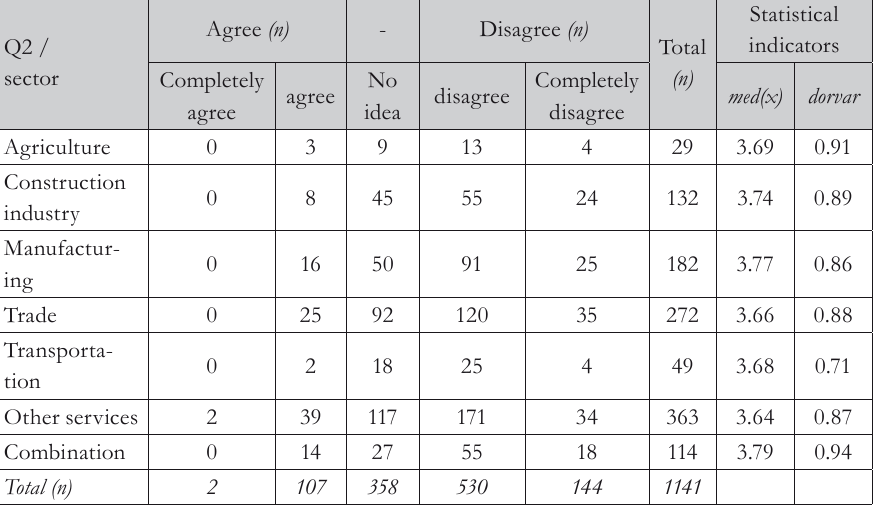
Tab. 5 – Pivot table for Q2a absolute frequency and Statistical characteristics. Source: authors Agree Q2 / 